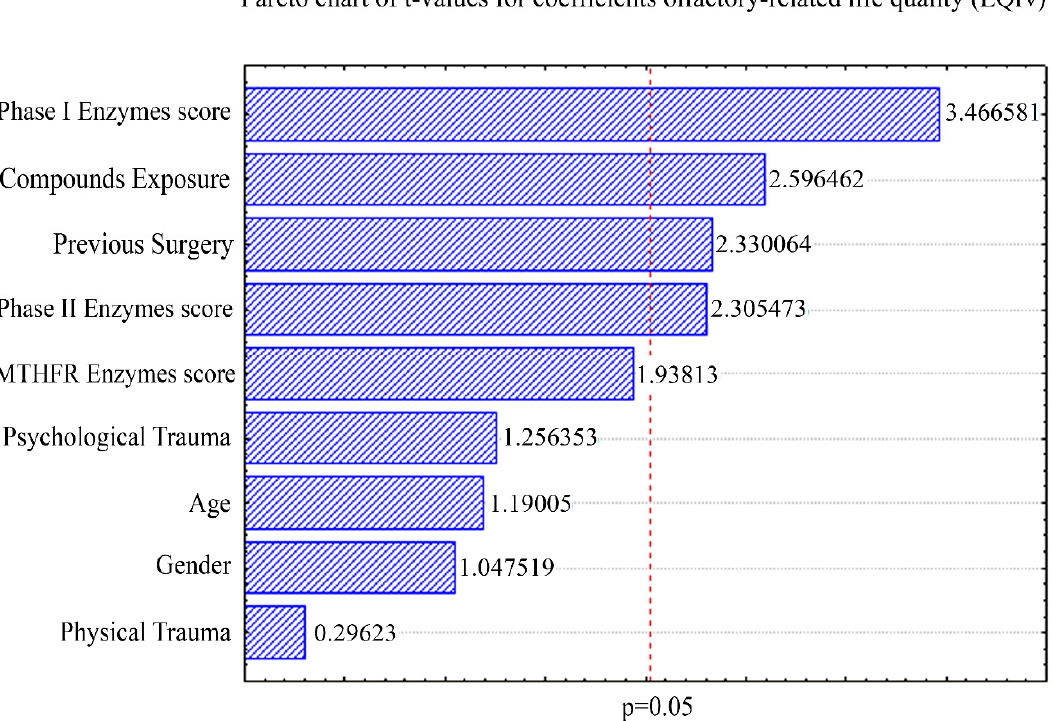
Table 4. Partial desirability model of main factors predicting olfactory-related quality of life in MCS patients.